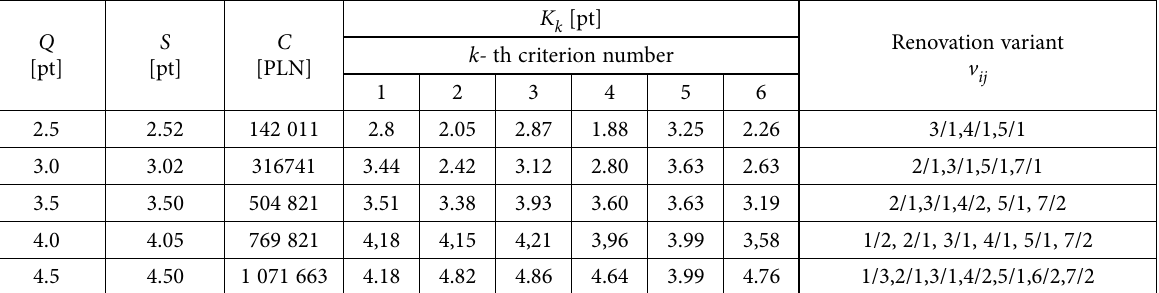
Table 4. The cost of renovation C for the assumed values of building condition S ≥